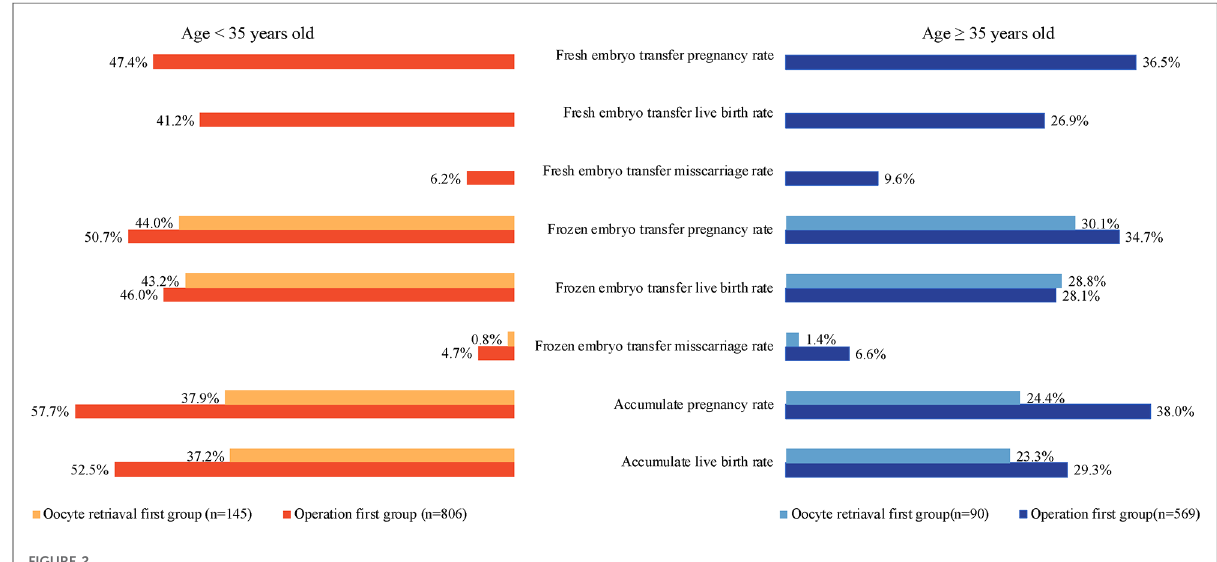
FIGURE 2 Outcomes of patients with bilateral hydrosalpinx in different age